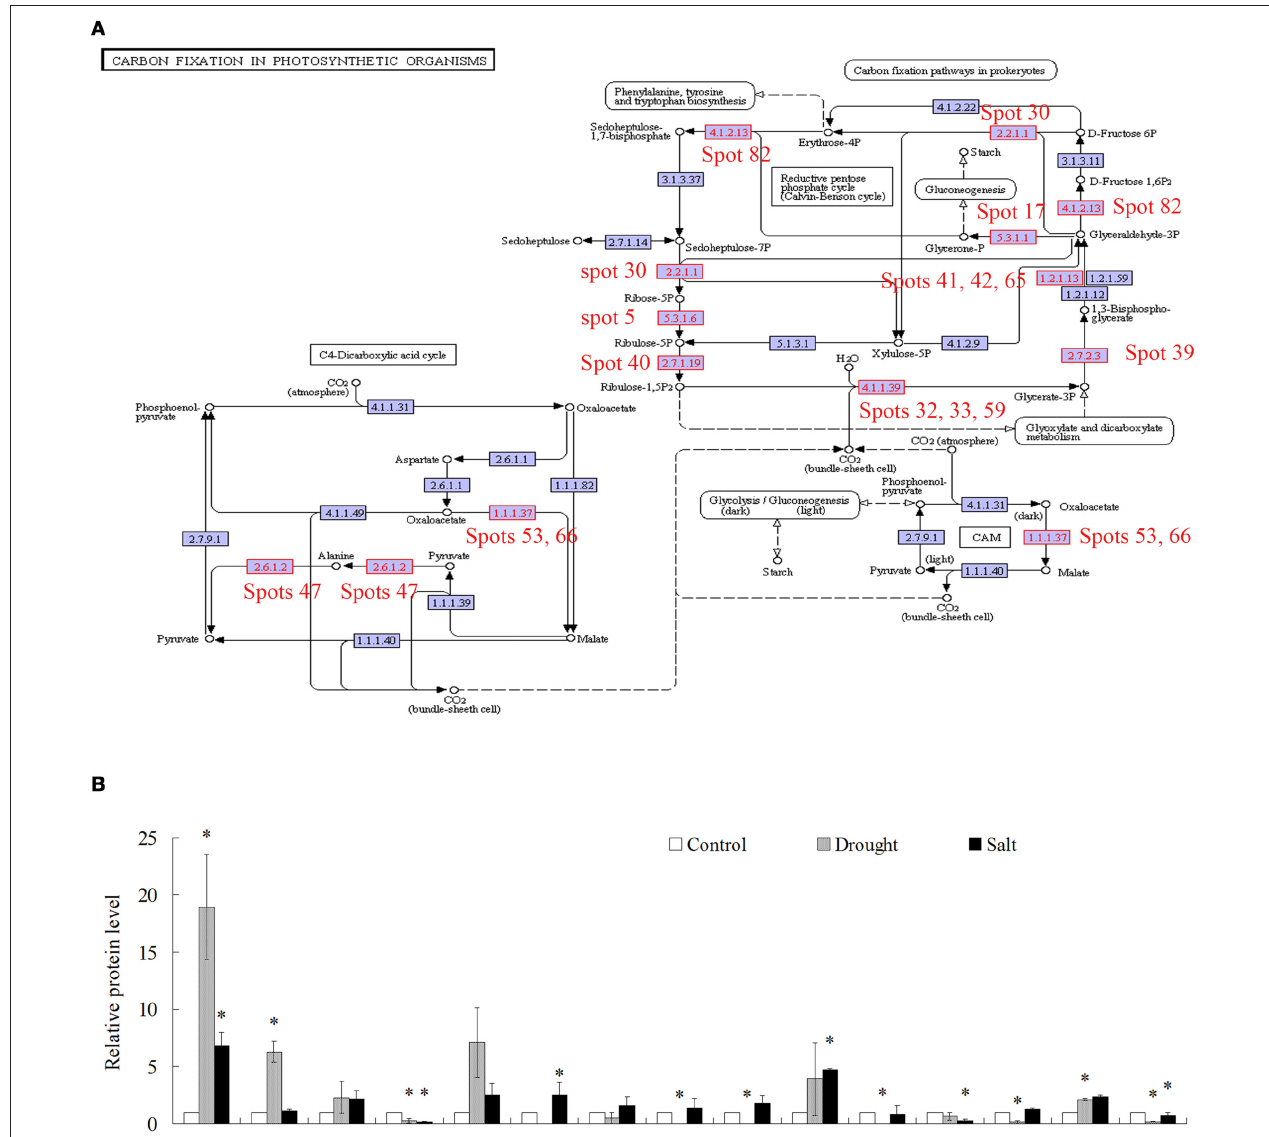
FIGURE 4 | Proteins whose abundance was changed by treatments of drought and salt were involved in carbon fixation in photosynthetic organisms. (A) Proteins changed by drought and salt treatments were involved in carbon fixation in photosynthetic organisms. (B) The relative protein levels of 15 proteins changed by drought and salt treatments. The results shown are the means ± SE, and the means are the average of three gels from three independent experiments. Asterisk symbols (*) indicate P < 0.05 ( t